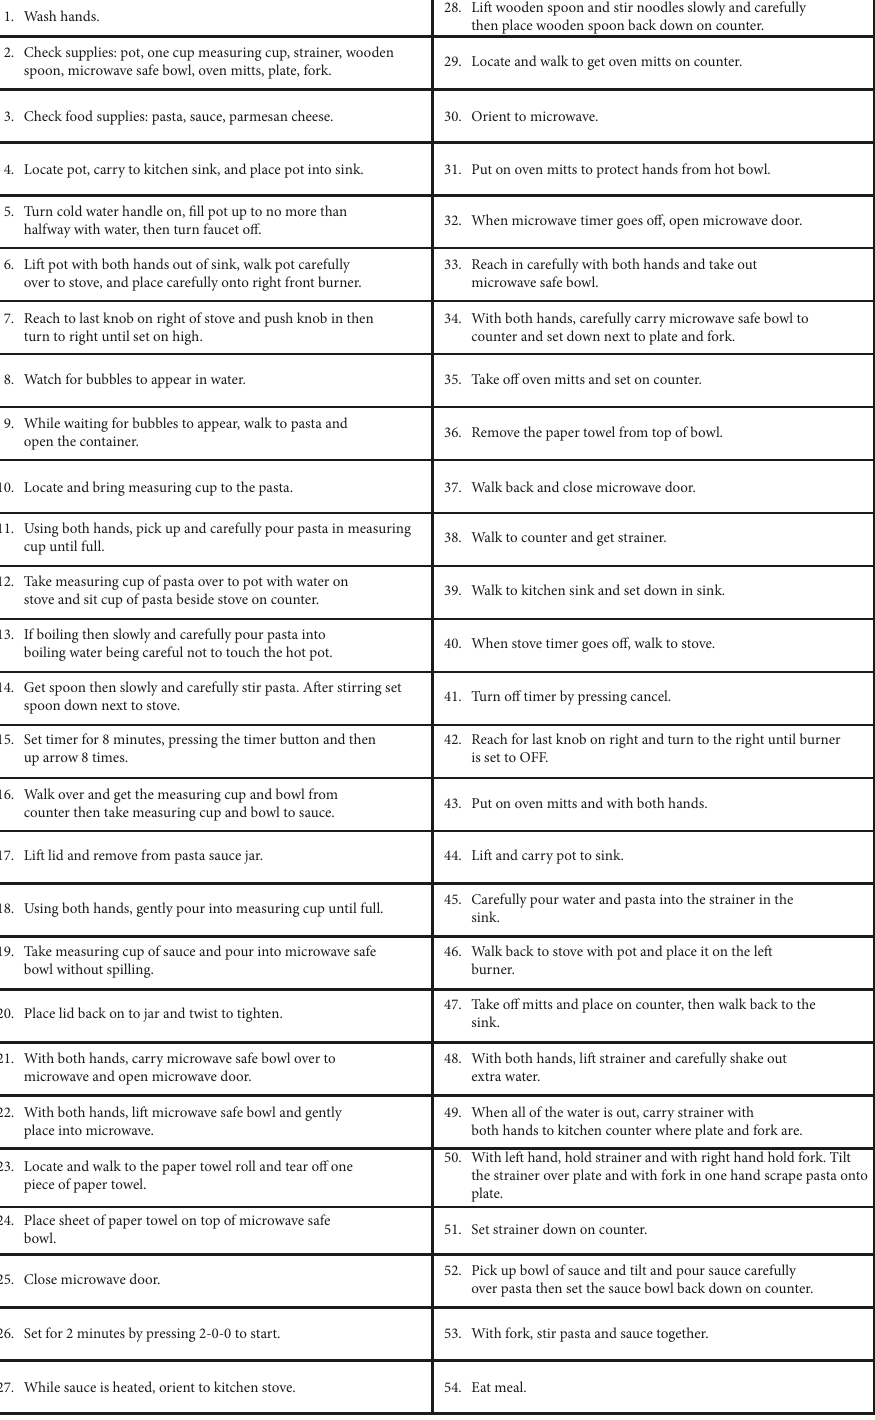
Figure 1: Task analysis for making